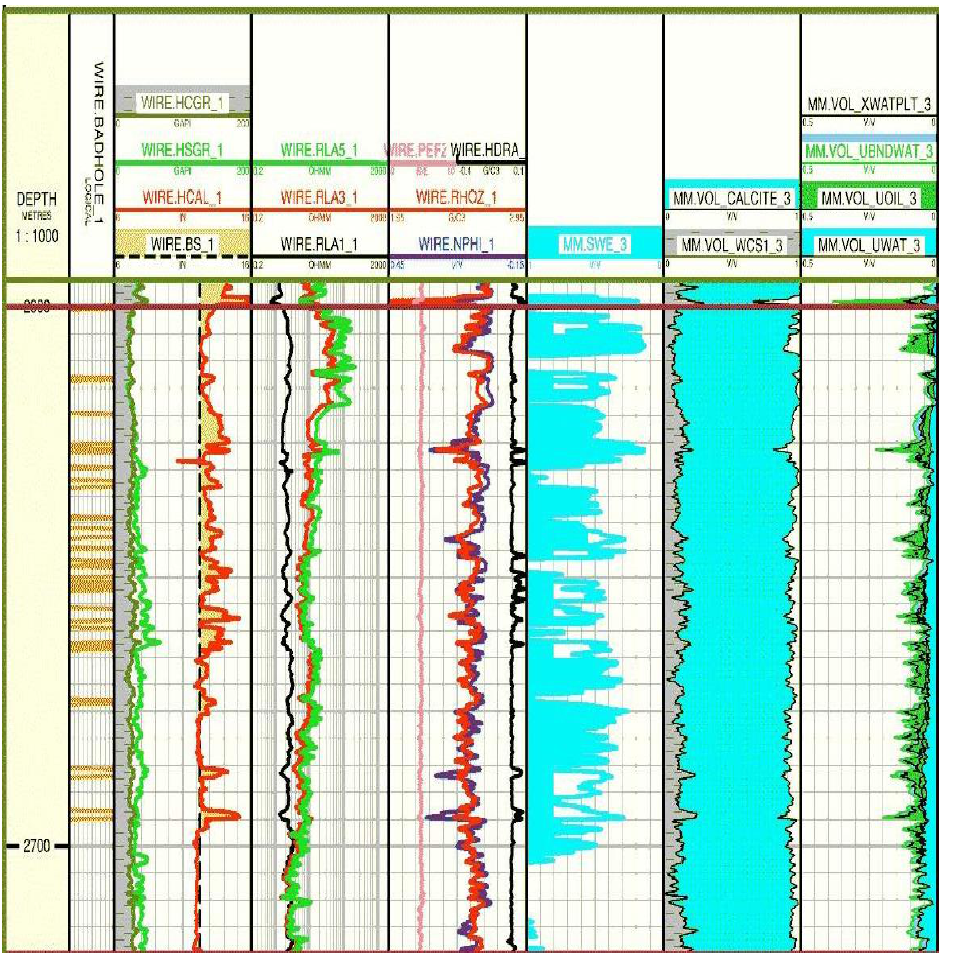
Figure 6. Full set evaluation results of reservoir designs and the separation well No.1 of Sarvak Formation